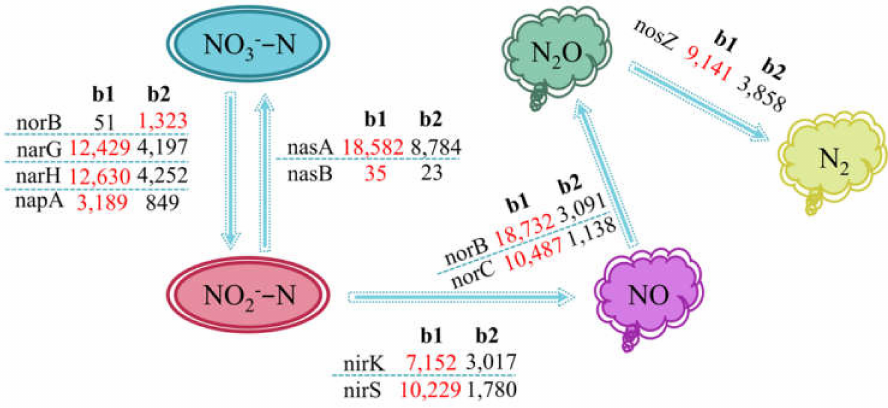
Figure 10. Nitrogen metabolism pathway